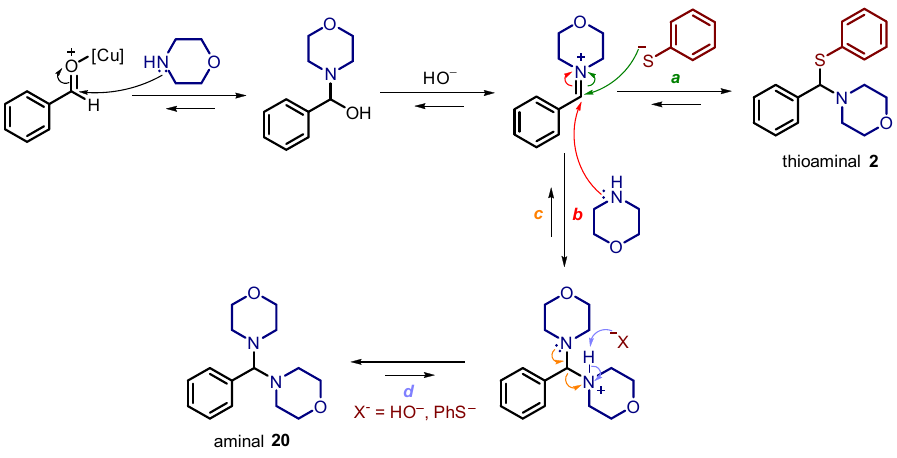
Figure 2. Proposed mechanism for the formation of thioaminals.